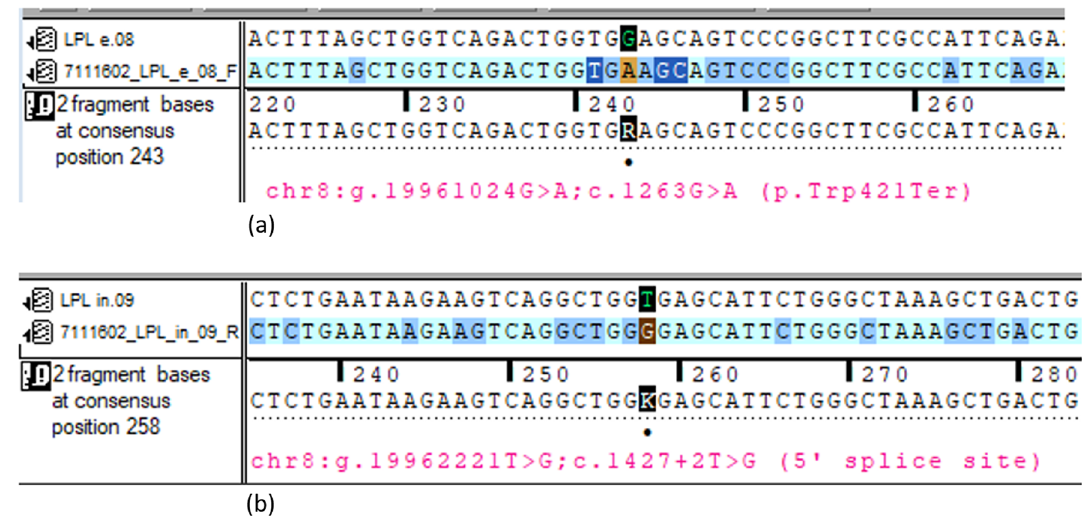
Fig. 5 a Sequence and alignment to reference sequence showing the variation in a exon 8 b intron 9 of the LPL gene in the index patient